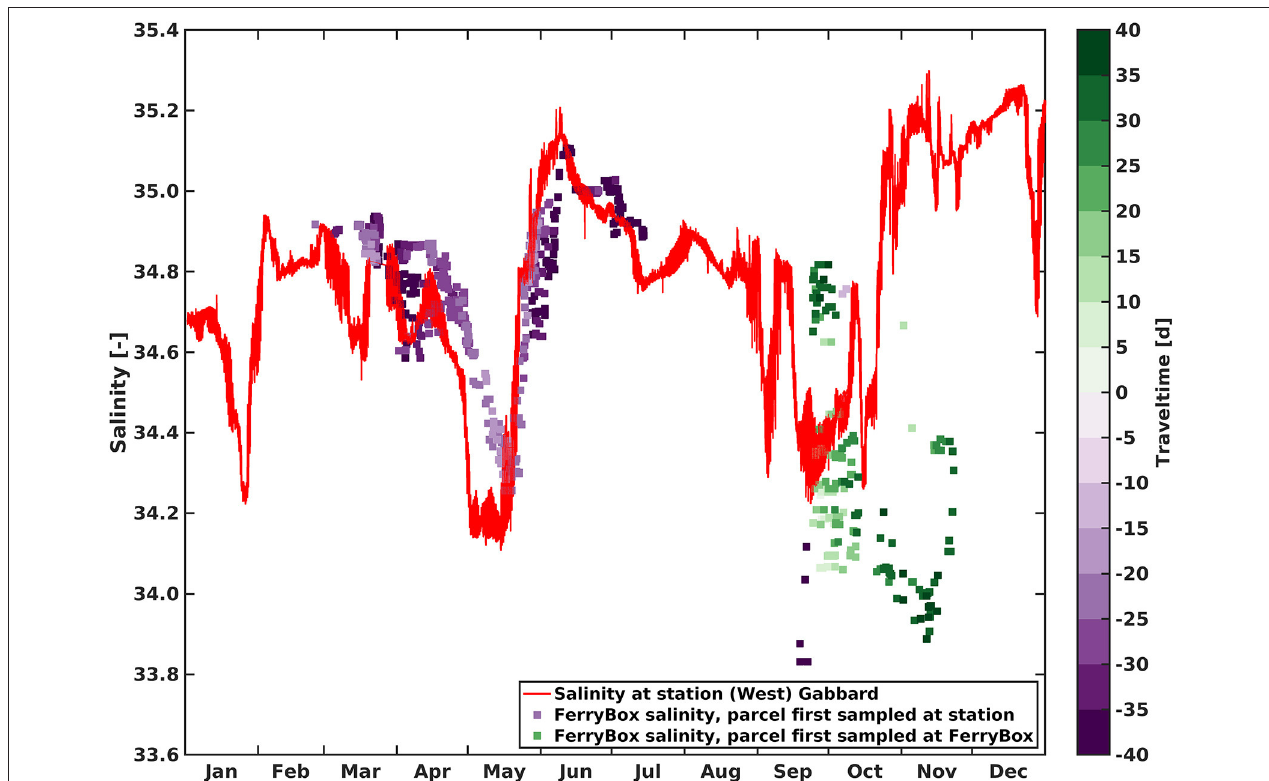
FIGURE 7 | Red: Salinity values observed at station Gabbard in the year 2002, copied from Figure 6 . Color-coded pixels indicate FerryBox observations for those water parcels that were also seen near Gabbard according to drift simulations based on hydrodynamic fields from TELEMAC-2D. The color code specifies estimated travel times either from the ferry transect to Gabbard (positive values, green) or from Gabbard to the ferry transect (negative values, purple). Compare the corresponding example trajectories shown in Figure 1